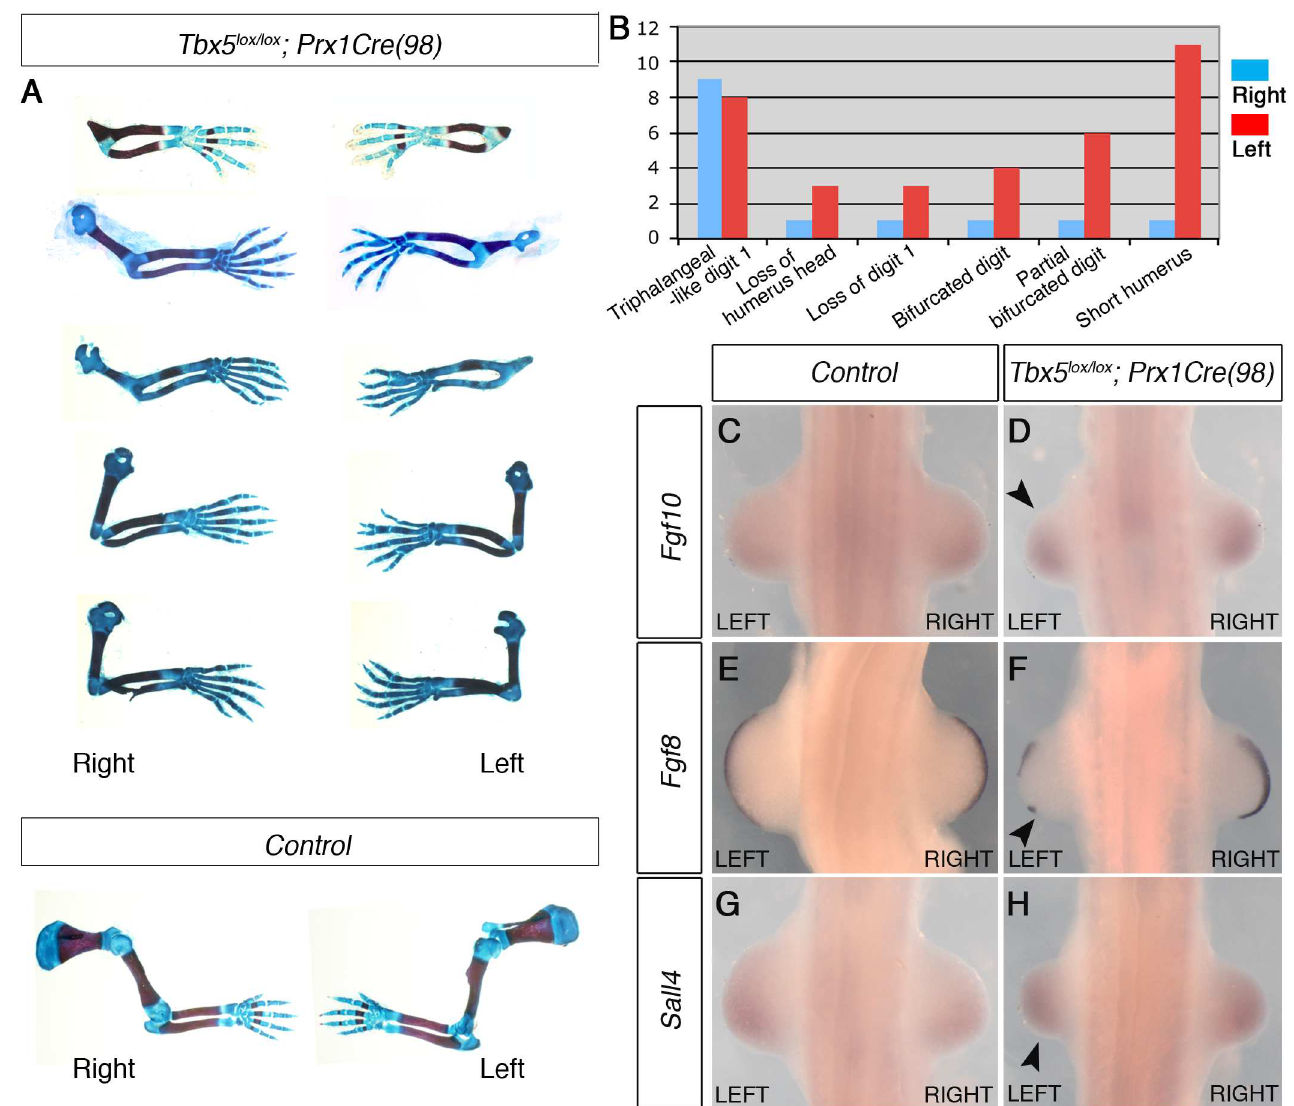
Fig 4. The mosaic and delayed deletion of Tbx5 results in the formation of left-biased forelimb defects. A , a selectionof 5 pairs of the left and right forelimbs of E17.5 Tbx5 lox/lox ;Prx1Cre(98) mutants and control embryos illustratingthe range in forelimbdefect severity. Mutant forelimbs are shown in descending order of severity from top to bottom. B , Tabulationof forelimbdefects observedin 18 mutant embryos. Defects are observed more frequently in the left than the right forelimbs. C-H, WISH analysisof E10.5 embryos. Left forelimbs are smaller than right forelimbs (n = 12) (arrowheads). Fgf8 expression is disruptedin left AER (F) while an obviousreduction of Fgf10 (D) and Sall4 (H) is not